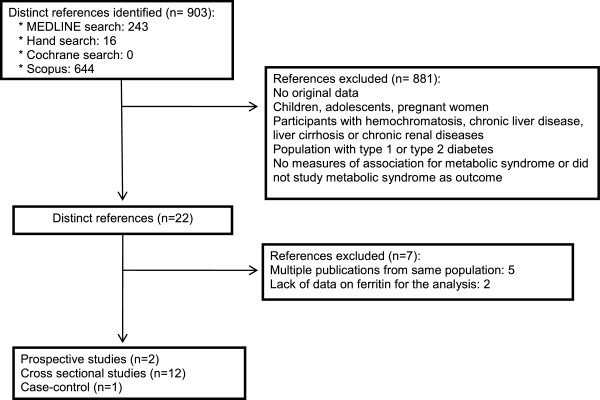
Flow diagram of the study selection process.